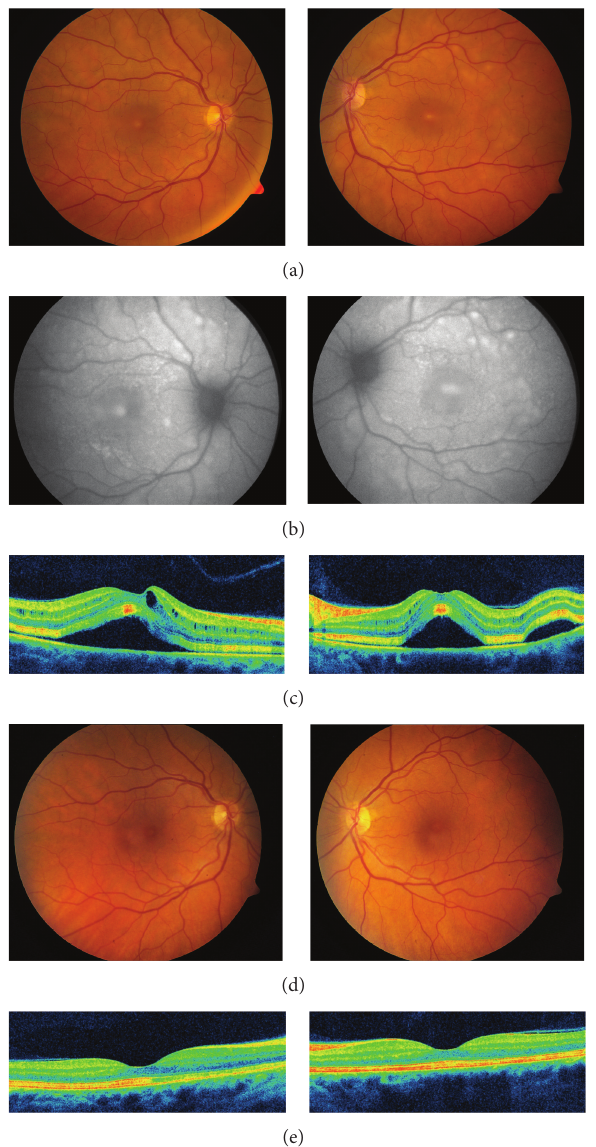
Figure 1: Color fundus photographs of the right and left eyes on full dose chemotherapy showed bilateral multifocal neurosensory detachments (a) seen on fundus autofluorescence as hyperautofluo- rescent areas (b). Optical coherence tomography (OCT) confirmed multiple neurosensory detachments with cystoid macular edema (c). After stopping chemotherapy, the neurosensory detachments resolved on fundus photographs (d) and OCT (e).